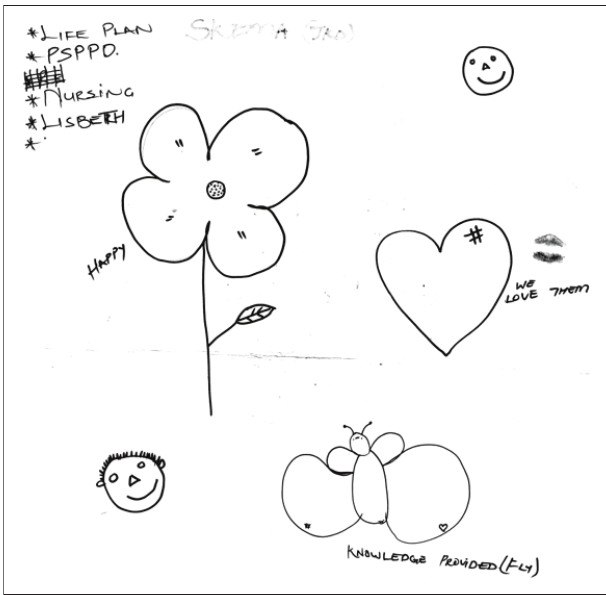
FIGURE 2: Jan Kempdorp focus group